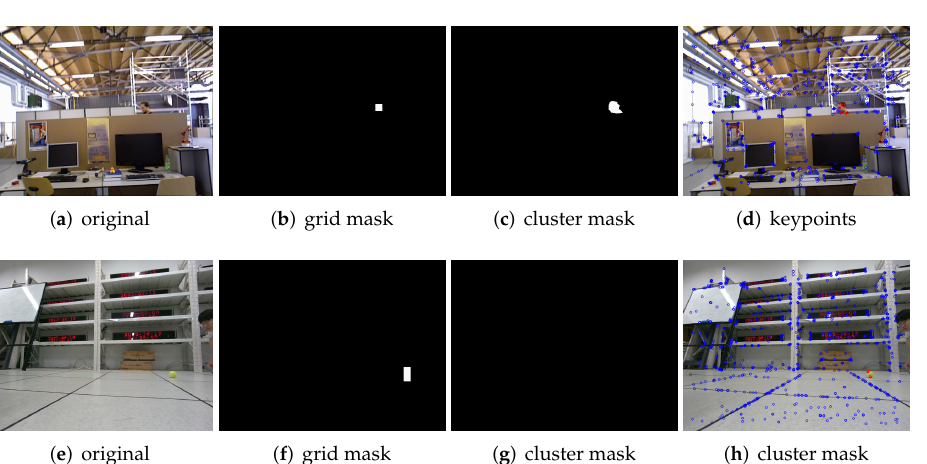
Algorithm 1. In Figure 7c, the white area indicates that the object is completely segmented